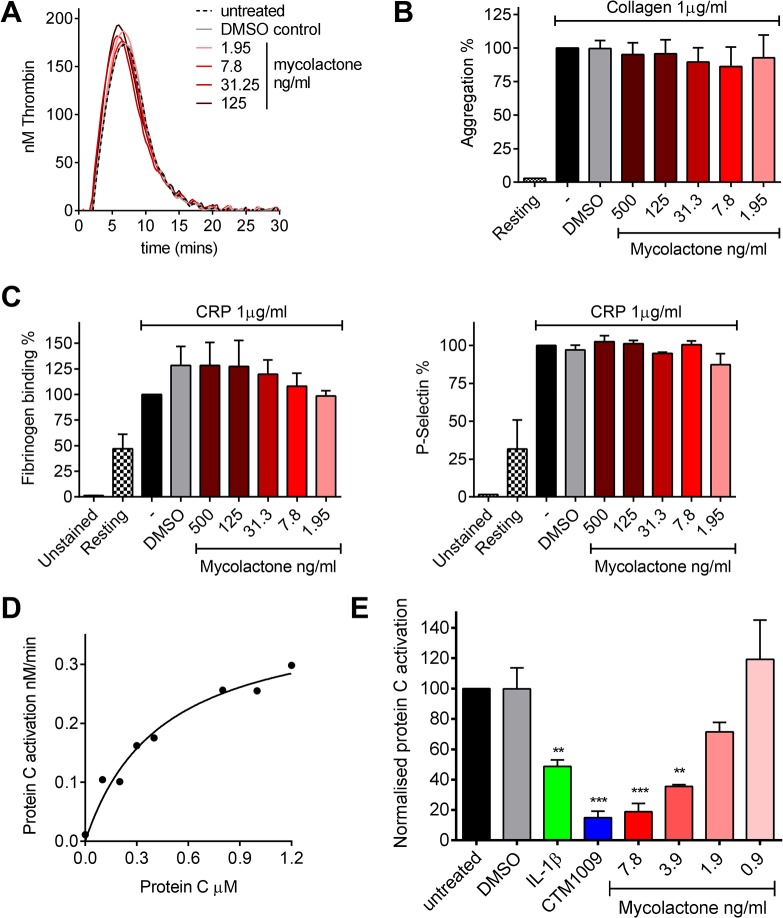
Mycolactone does not affect thrombin generation per se but profoundly inhibits the ability of endothelial cells to activate protein C.A. Thrombin generation was measured by calibrated automated thrombography. Thrombin generation was quantified in human pooled plasma containing various concentrations of mycolactone or 0.013% DMSO as a control. The experiment was initiated with 4pM tissue factor, 4μM phospholipid vesicles, and 16.6mM CaCl2. Thrombin generation was monitored using 0.42mM of the fluorogenic substrate Z-GlyArg-AMC-HCl as described in the text. B. Platelet aggregation was assessed using an optical platelet aggregometer by the addition of 1μg/ml collagen to washed human platelets that had been treated with various concentrations of mycolactone or 0.1% DMSO as a control, and are expressed relative to an untreated control. Mean±SEM n = 3 (except for resting platelets where n = 1). C. Platelet activation was determined by quantifying fibrinogen binding to, and P-selectin exposure on, human platelets by flow cytometry. Washed human platelets were treated with various concentrations of mycolactone or 0.1% DMSO as a control then stimulation with 1μg/ml CRP-XL, and are expressed relative to an untreated control. Mean±SEM n = 3. D and E. Protein C activation over human dermal microvascular endothelial cells. Protein C was added to cells in the presence of Ca2+ and Mg2+. Activation was initiated by the addition of 13.5nM thrombin and proceeded for 30 mins at which point the reaction was stopped 5μg antithrombin and 3U heparin. Activated protein C was quantified by assessing the rate of chromogenic substrate S2366 cleavage compared to an APC standard curve. D. Michaelis-Menton curve of protein C activation. E. Cells were exposed to various concentrations of mycolactone (MYC), 10ng/ml IL-1β or 0.025% DMSO (solvent control) for 24 hours. In one case, untreated cells were exposed to a function-blocking antibody (CTM) for 1hr prior to the assay. Protein C (5nM) activation was assessed as before and is expressed as % of untreated cells. Mean±SEM n = 3.